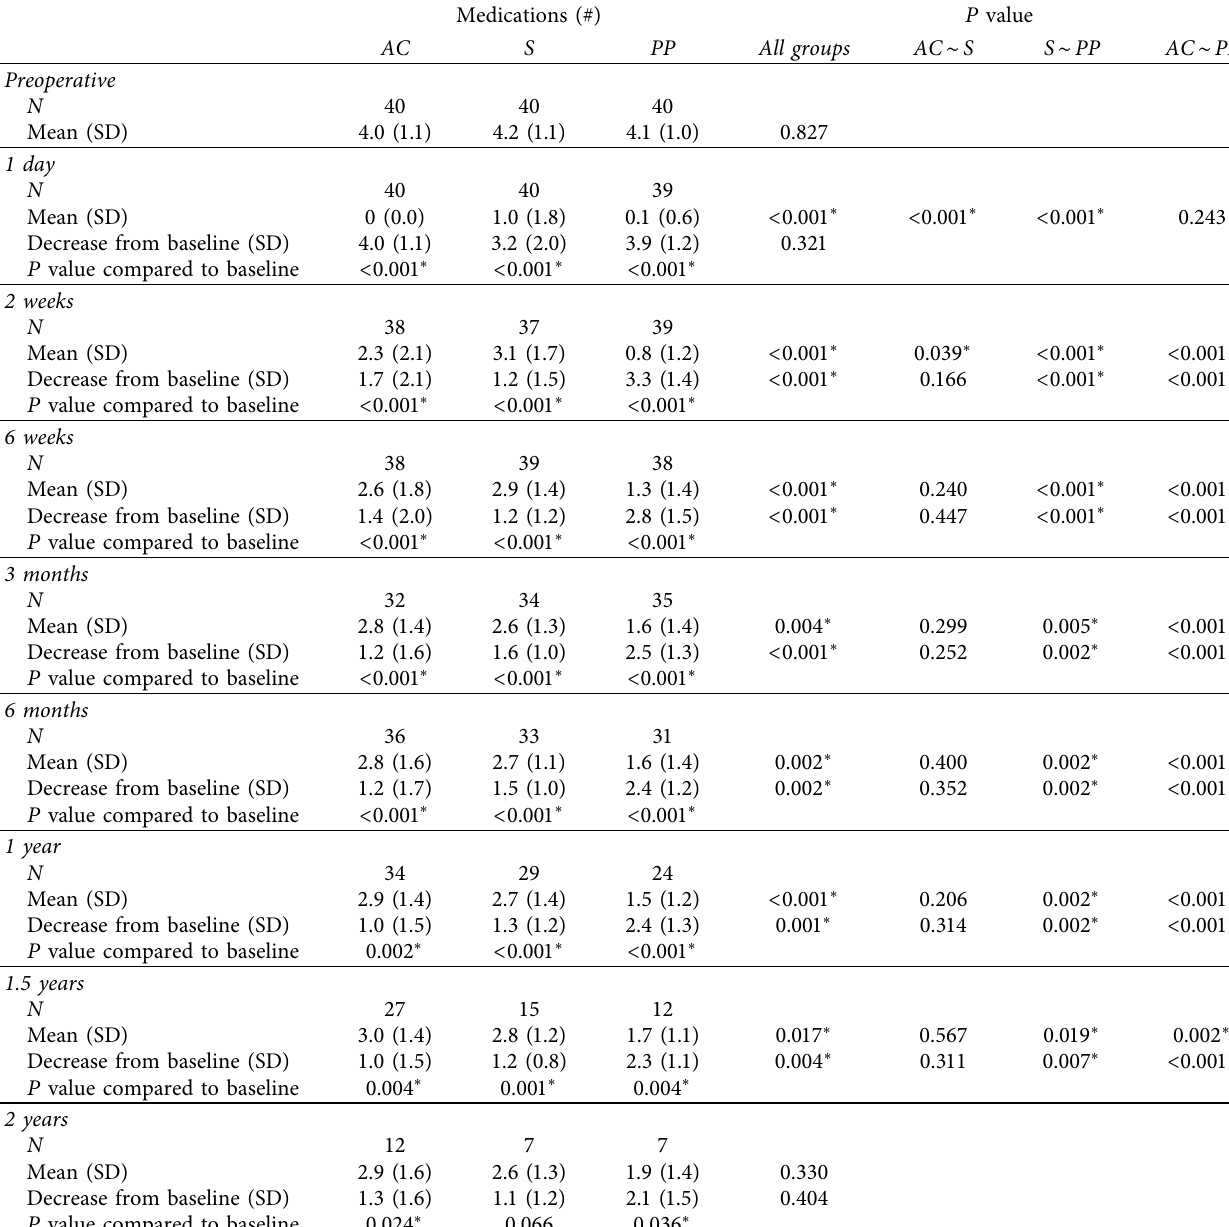
Table 4: Medication burden outcomes data a